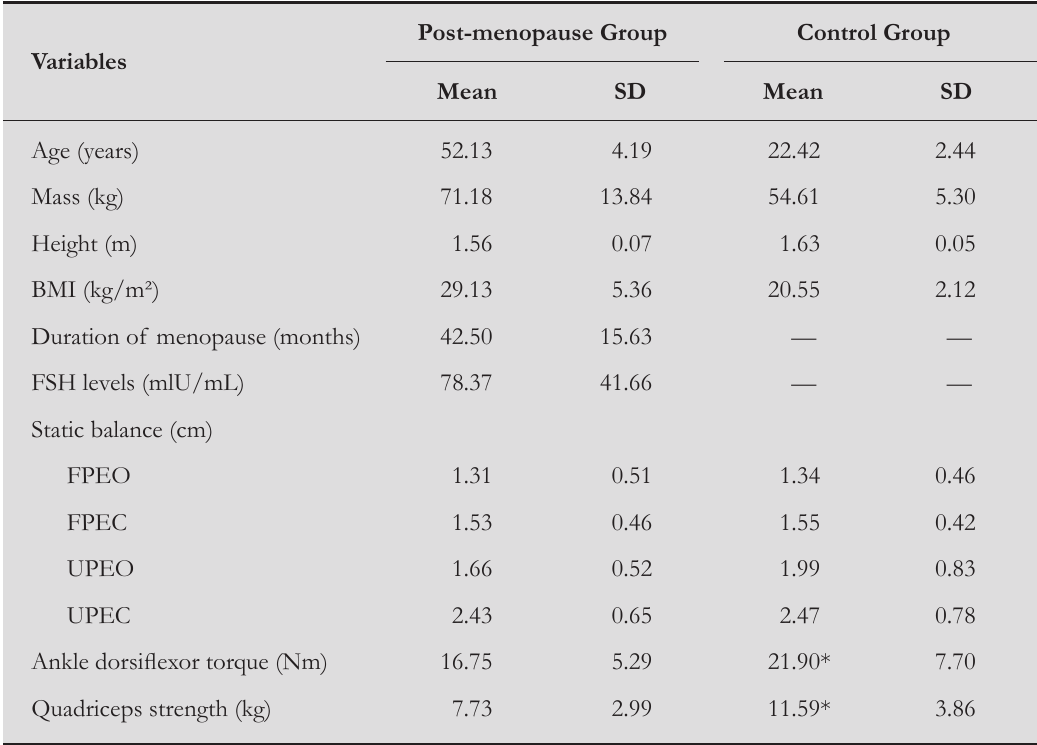
Table 1 - Variables with respective means and standard deviations (SD) for post-menopausal and fertile women